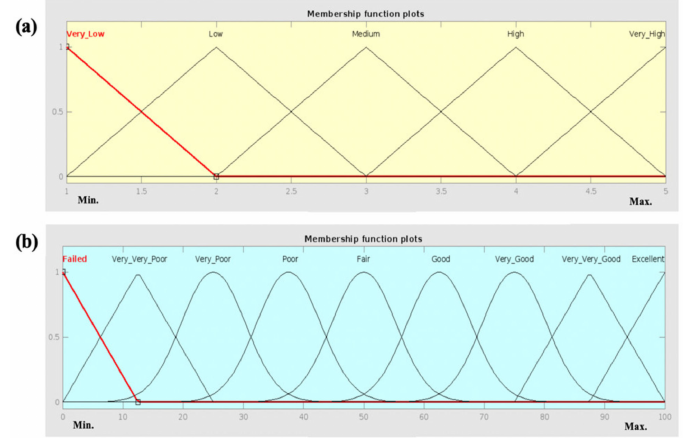
Figure 4. Membership functions of the fuzzy model FSL-CPi: ( a ) inference functions of the input variables (I1–I5); ( b ) inference functions of the output variables (FSL-CPi).